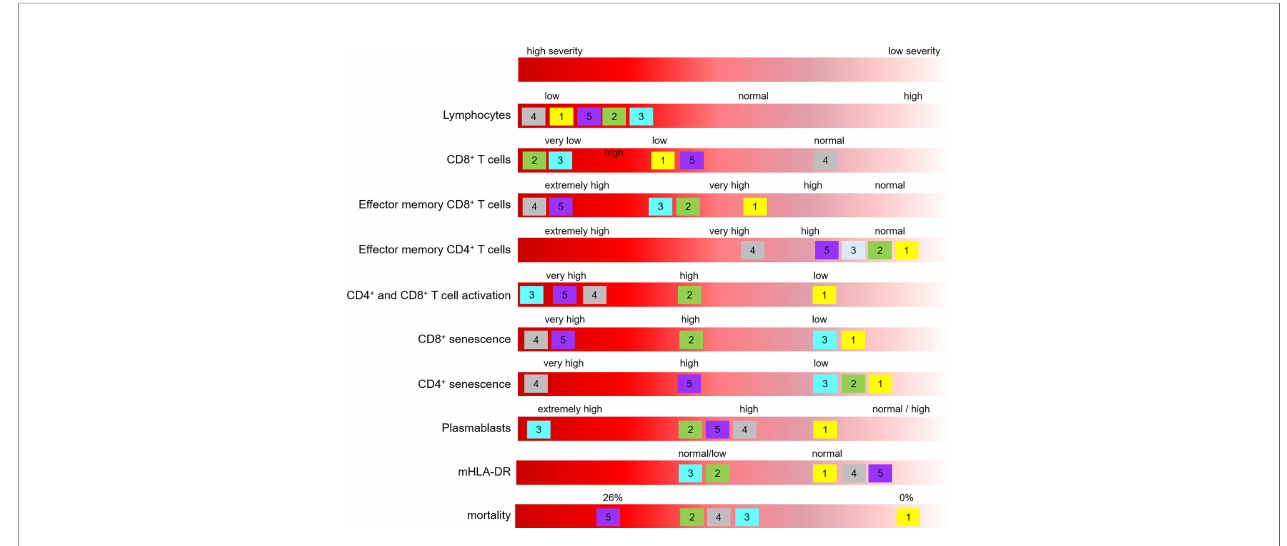
FIGURE 3 | Main characteristics de fi ning the fi ve clusters based on immunophenotypic pro fi le. Clusters are identi fi ed with their number, and positioned according to the mean value of the corresponding